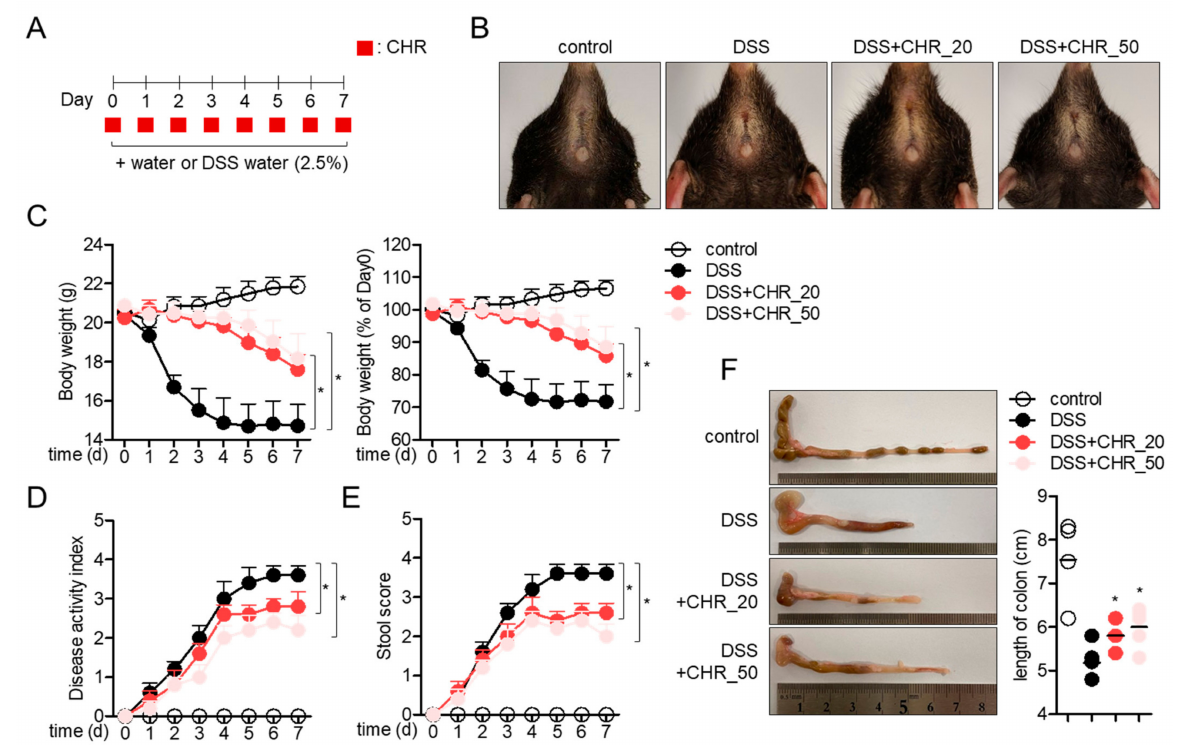
Figure 4. Oral administration of chrysophanol protects mice from DSS-induced IBD in vivo. ( A ) The scheme of IBD experiment using 2.5% DSS-containing water and oral administration of chrysophanol for 7 days. ( B ) The representative picture of mice anus at 7-day post exposure to 2.5% DSS-containing water and oral administration of chrysophanol. Control mice group treated with fresh drinking water, DSS mice group treated with drinking water containing 2.5% DSS for 7 days, DSS + CHR_20 mice group treated with drinking water containing 2.5% DSS and daily orally administered 20 mg/kg chrysophanol for 7 days, and DSS + CHR_50 mice group treated with drinking water containing 2.5% DSS and daily orally administered 50 mg/kg chrysophanol for 7 days ( n = 5 mice/group). ( C ) The changes of mice body weight during exposure to DSS-containing water and oral administration of chrysophanol for 7 days (left) and the ratio of mice body weight (% of Day 0) (right). ( D ) The changes of disease activity index during exposure to DSS-containing water and oral administration of chrysophanol for 7 days. ( E ) The changes of mice stool during exposure to DSS-containing water and administration of chrysophanol for 7 days. ( F ) The representative pictures of mice colons at 7-day post exposure to DSS-containing water and oral administration of chrysophanol. The mean value of five mice ± SEM is presented. * p < 0.05 compared with DSS-treated